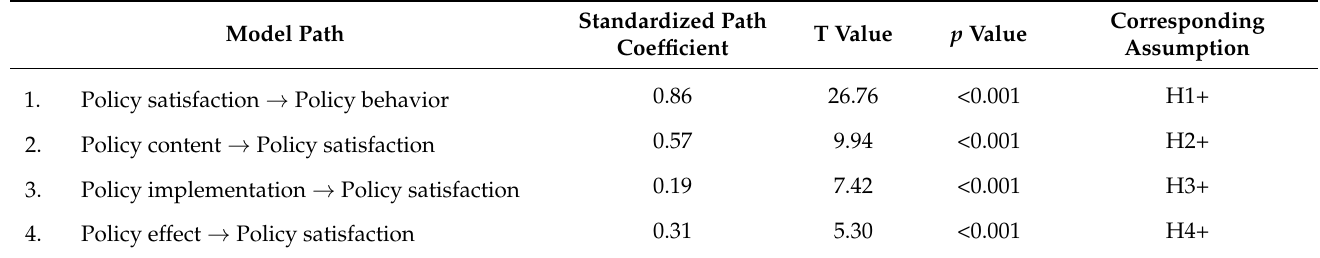
Table 3. Standardized path coefficient of school sports policy attitude structure model ( n =